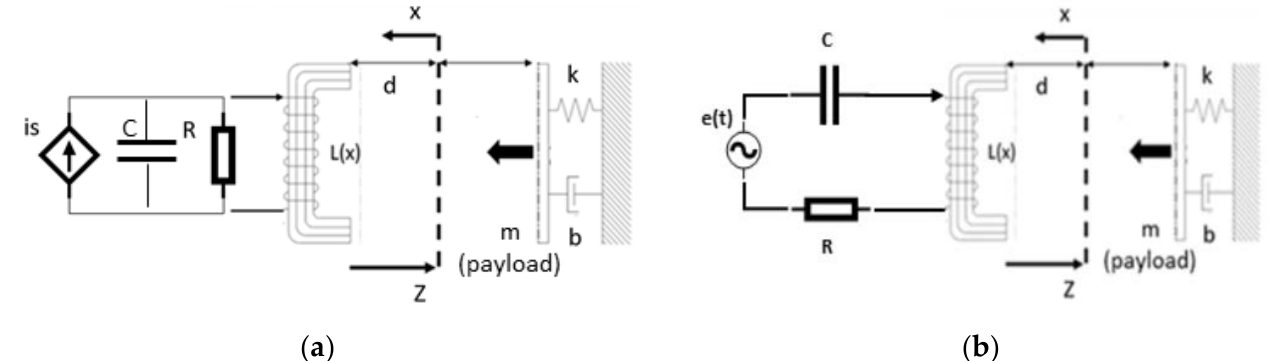
Figure 1. ( a ) Coupled electromechanical oscillator investigated in this work; ( b ) coupled electromechanical oscillator as described in